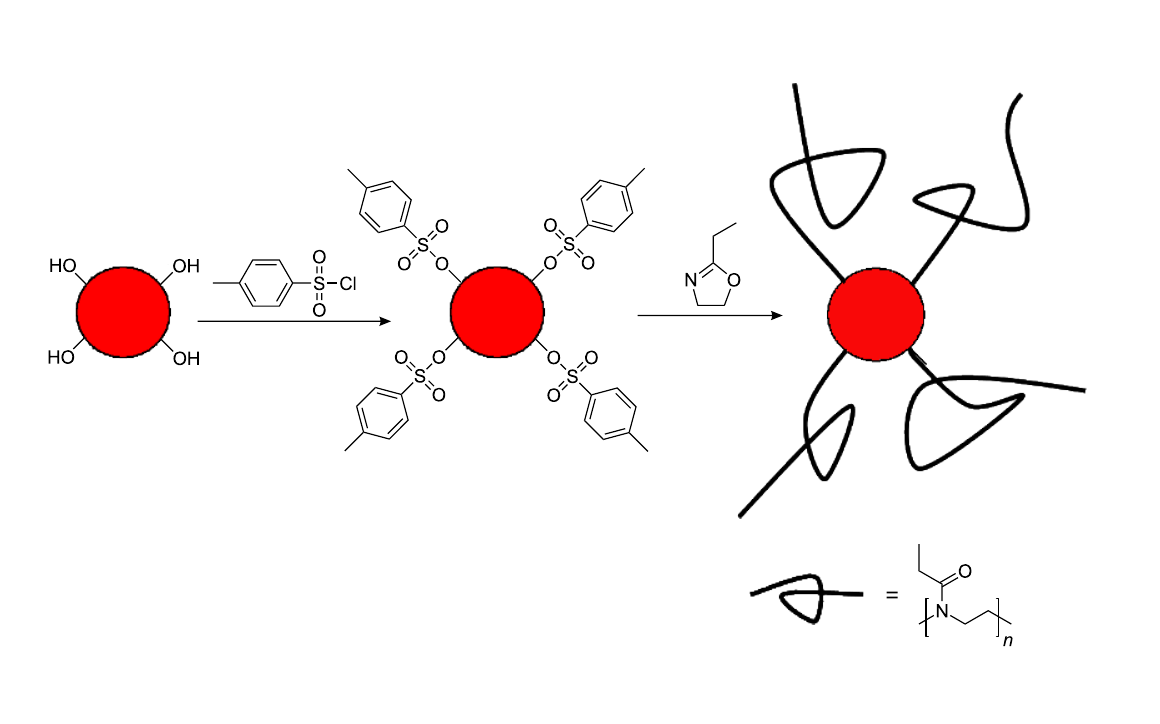
Figure 1: Schematic representation of the investigated strategy for the synthesis of star-shaped poly(2-ethyl-2-oxazoline)s based on multi-tosylate ini-